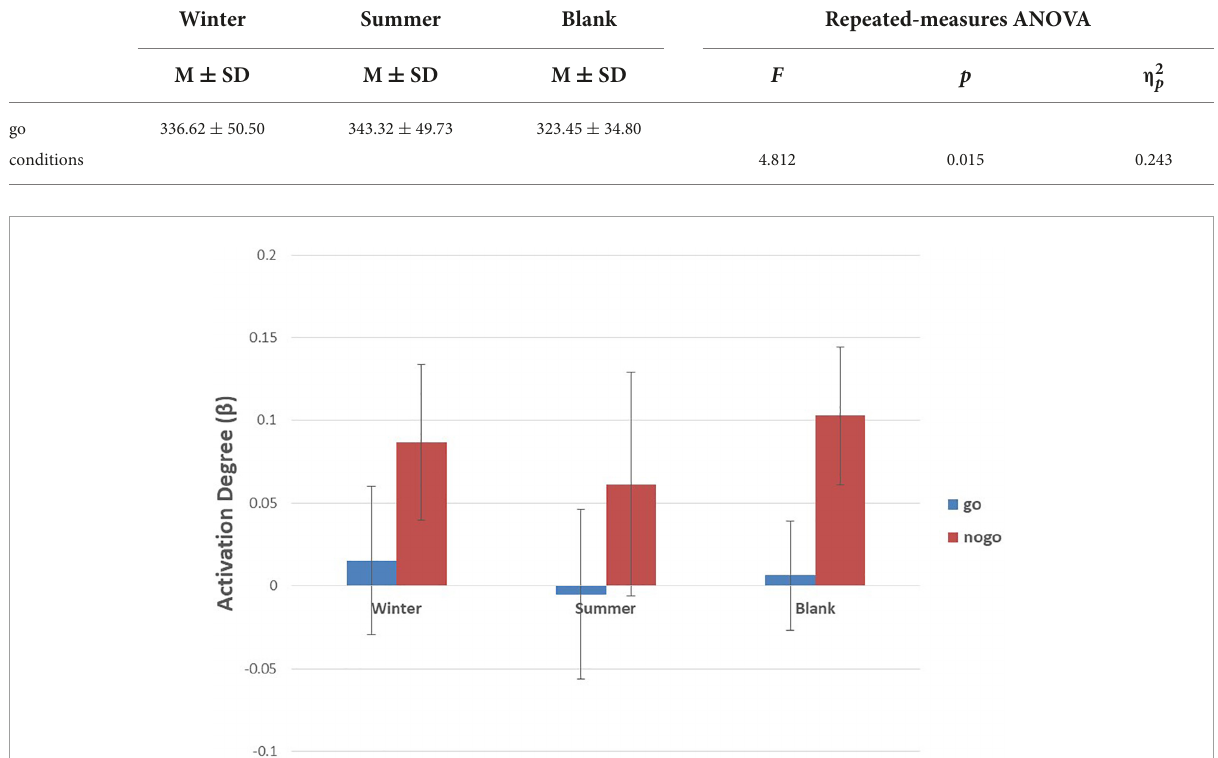
TABLE 3 Repeated measures ANOVA of reaction time.